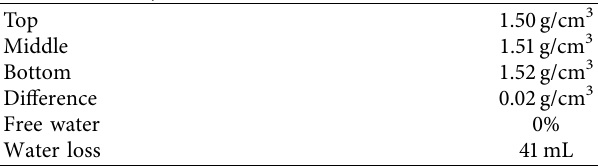
Figure 3: Thickening time (271min) of the cement slurry containing 2% Table 7: Free water and slurry sedimentation experiments using the cement slurry.